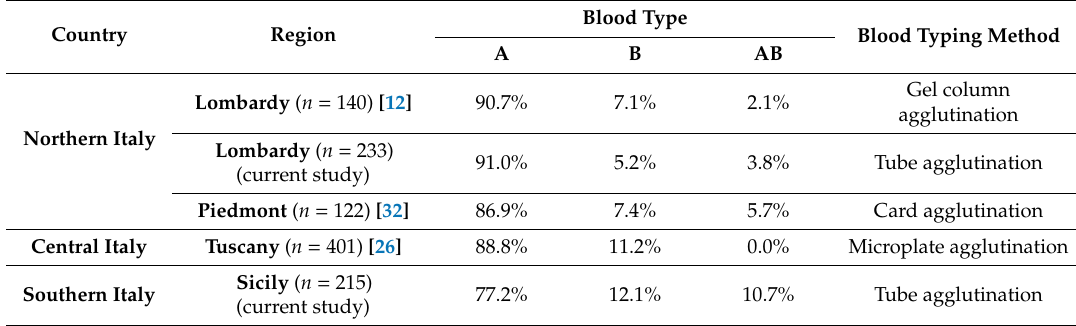
Table 2. Prevalence of blood types of AB blood group system in non-pedigree DSH cats